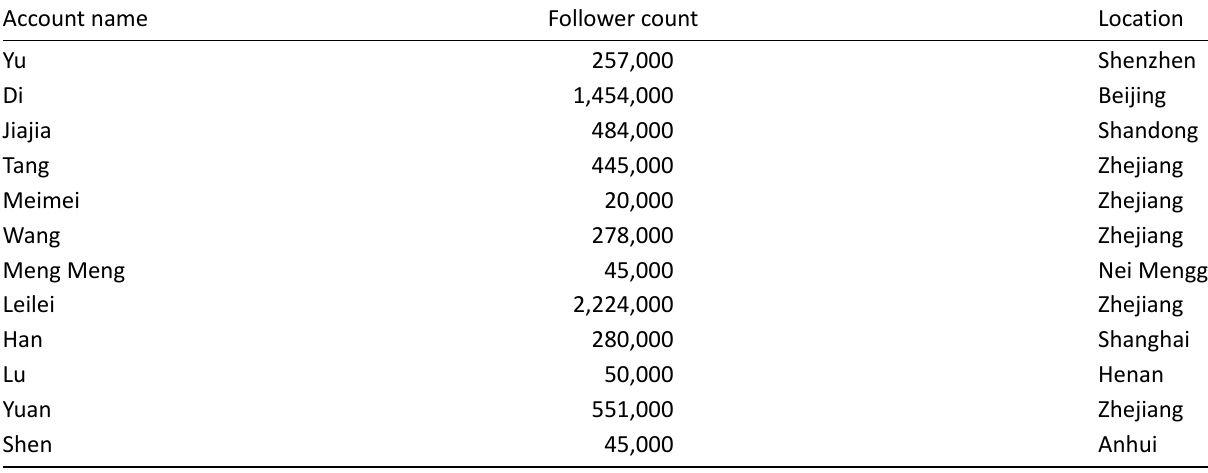
Table 1. List of vlogger accounts (data retrieved on 31 December